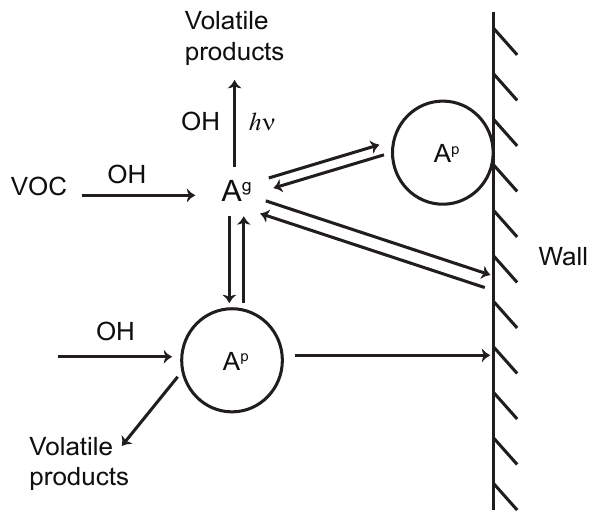
Fig. 8. Sources and sinks of a semivolatile gas-phase species, A g , and particles containing the condensed semivolatile species, A p , during SOA aging. We do not explicitly indicate in the sketch processes by which the particle-phase A p attains a semisolid state, greatly affecting continued exchange with the gas phase (Virtanen et al., 2010; Vaden et al., 2010, 2011; Shiraiwa et al.,